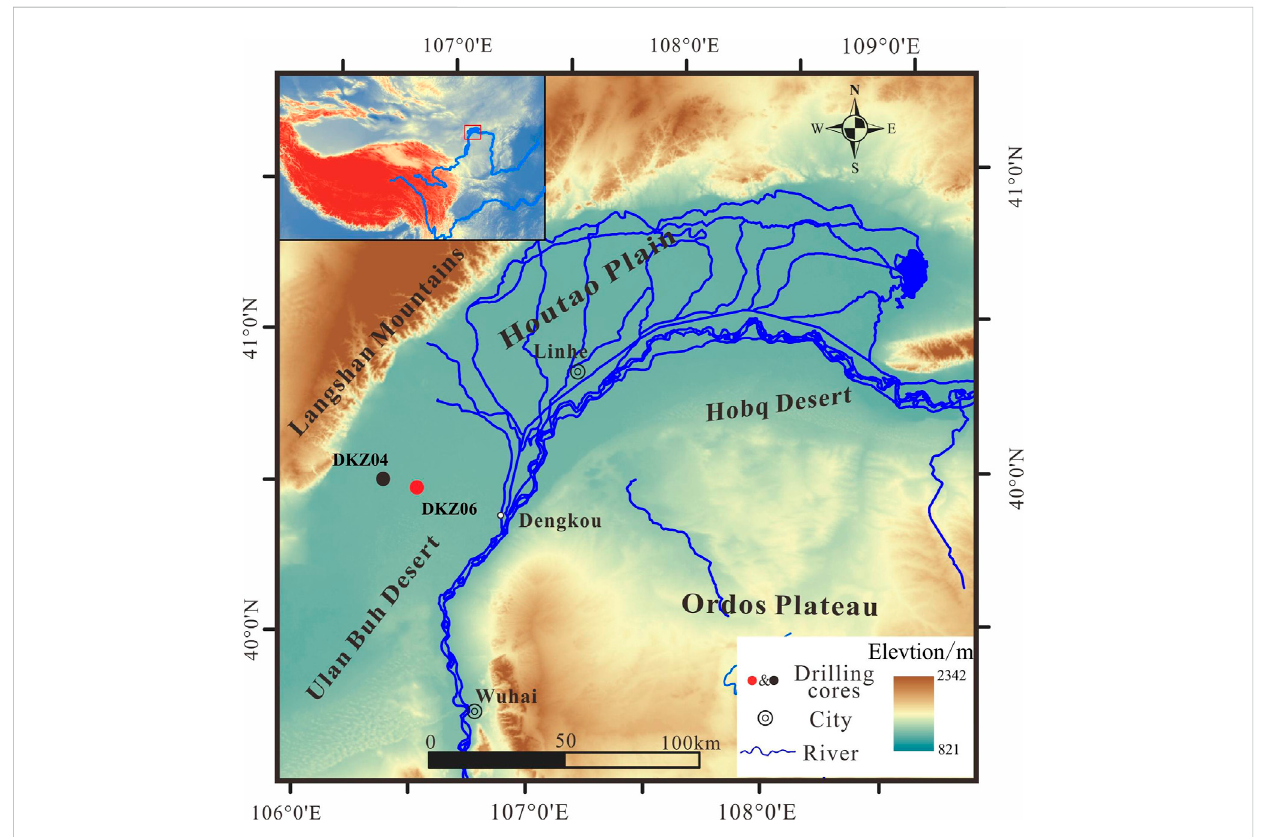
FIGURE 1 Topographic map of the Houtao Plain and its surroundings. The location of the drilling core DKZ06 is shown by a red dot, and the locations of the core DKZ04 (Li et al., 2019) referenced in the text are shown by a black dot. The inset box shows the location of the study area ( fi lled